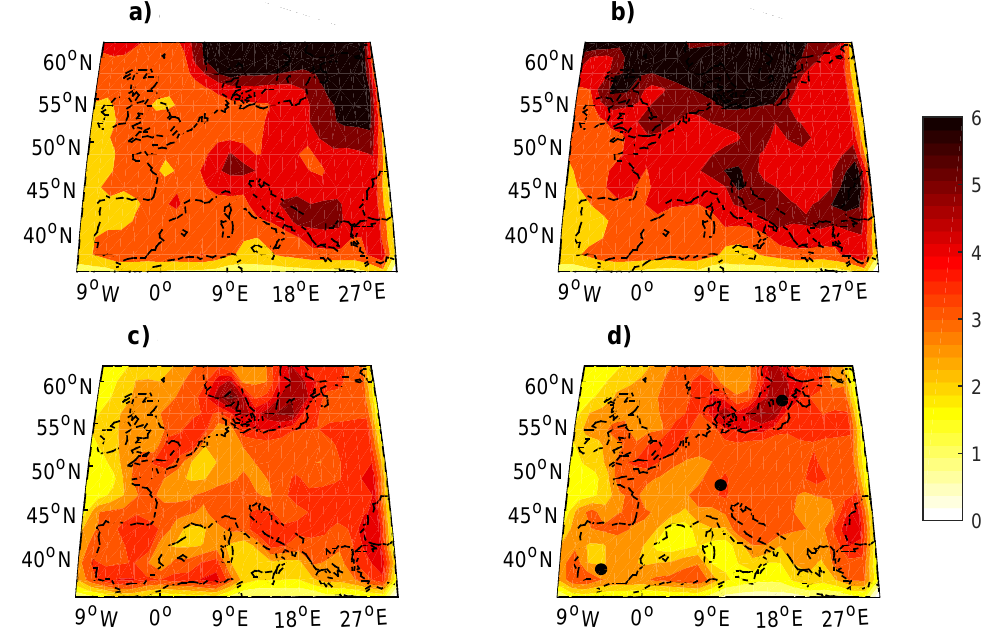
Figure 7. Standard deviation of the biases of models SDM for T max for hot temperature extremes ( a , b ) and SDM for T min for cold temperature extremes ( c , d ). Different bin length m are represented: 1 year ( a , c ) and 4 years ( b , d ). Detailed statistical information about this figure in Table 3 (Ensemble). The three black dots in ( d ) correspond to central (Figure 2a), northern (Figure 2b), and southern (Figure 2c) points of Figure